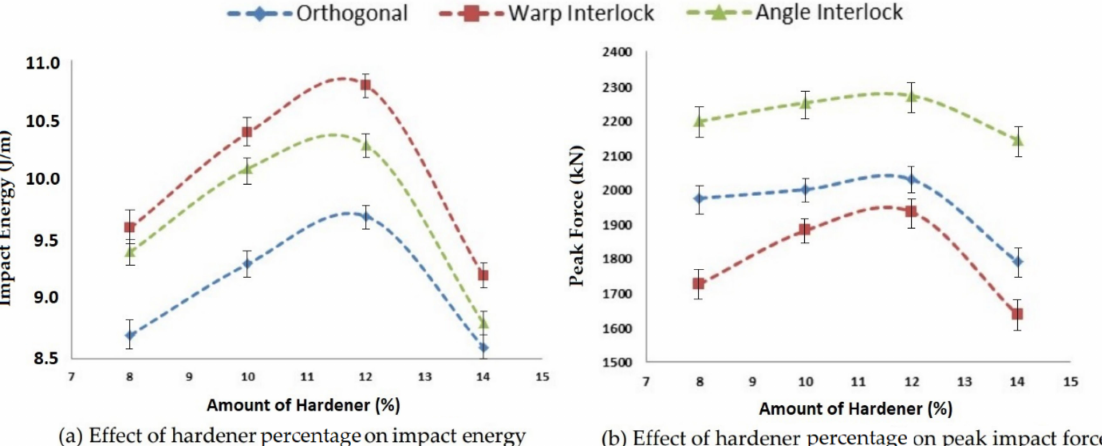
Figure 13. Effect of the amount of hardener percentage on the impact properties of 3D woven